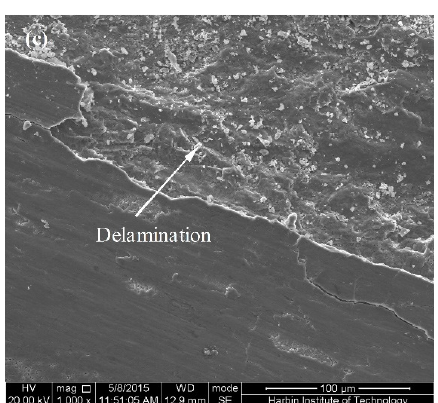
Figure 14. Worn surface morphology of the thixoformed composite parts at different sliding velocities: ( a ) 0.8 m/s, ( b ) 1.2 m/s and ( c ) 1.6 m/s.